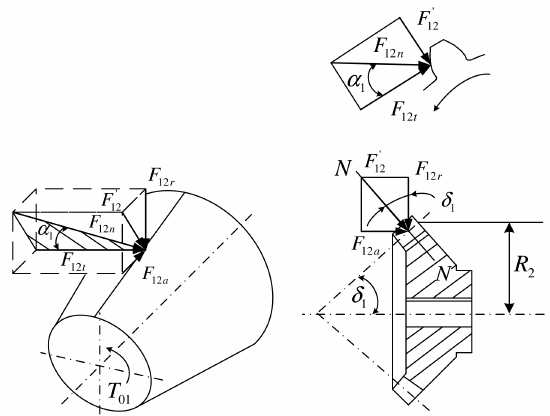
Figure 4. Force analysis of the bevel gear teeth.